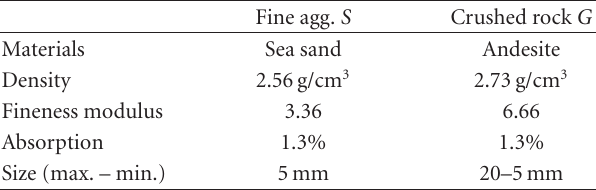
Table 2: Properties of